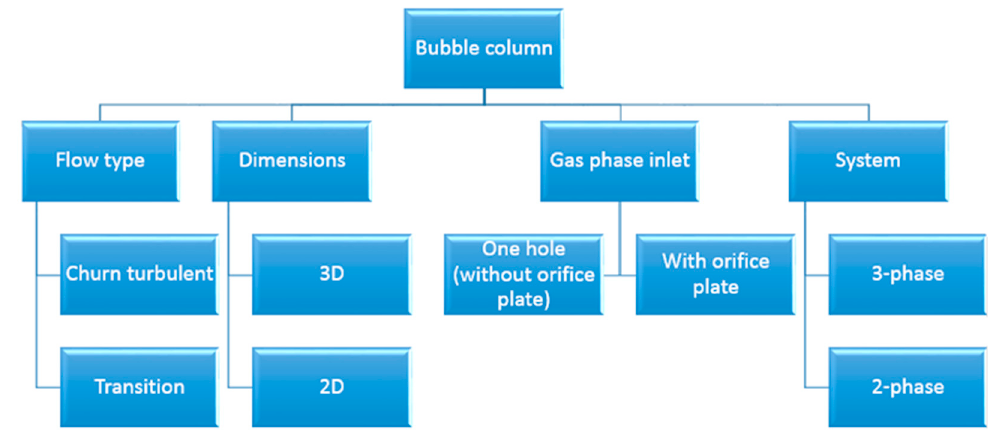
Figure 2. Laboratory investigation of bubble column.